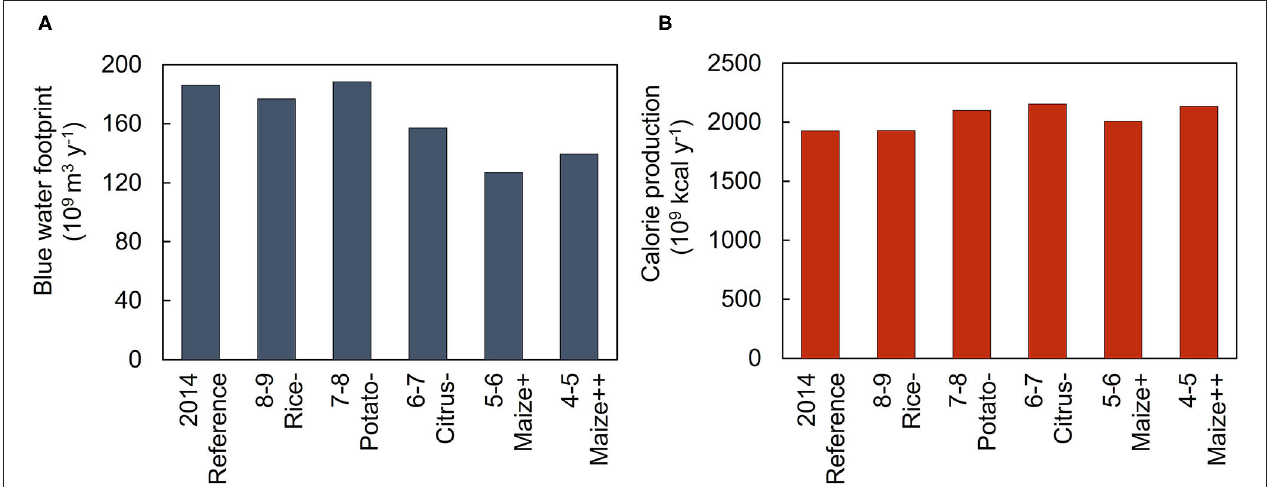
FIGURE 7 | Total BWF of crop production (A) and CP (B) under different crop production